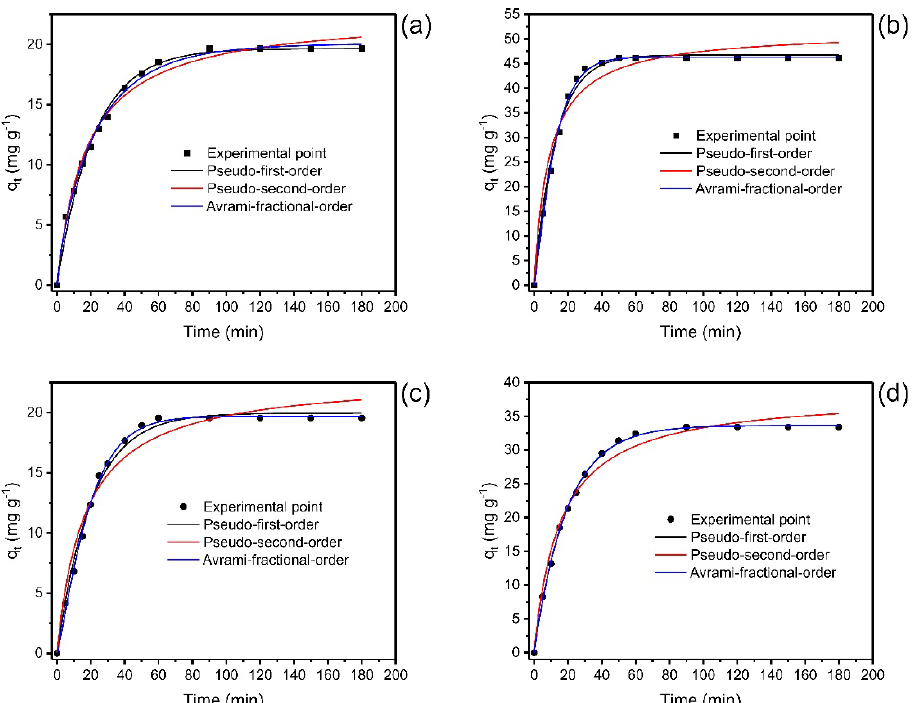
Figure 5. Kinetics curves for the biosorption of Nd(III) onto LEB − 18 S. platensis ( a , b ) and LEB − 52 S. platensis ( c , d ). Initial concentration 20.0 mg L −1 ( a , c ) and 50.0 mg L −1 ( b , d ). Conditions: initial pH 6.0; temperature 25 °C; adsorbent dosage 2 g L −1 .